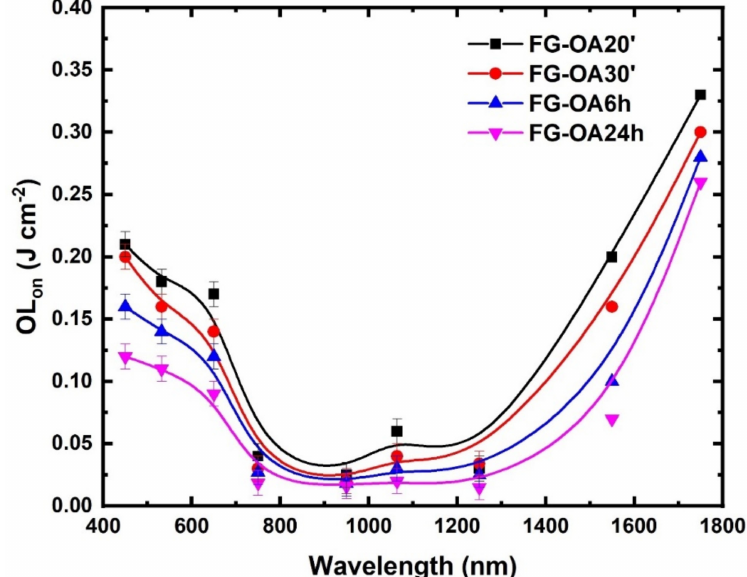
Figure 7. Variation of the optical limiting onset (OL on ) of the FG-OAx derivatives with the irradiation